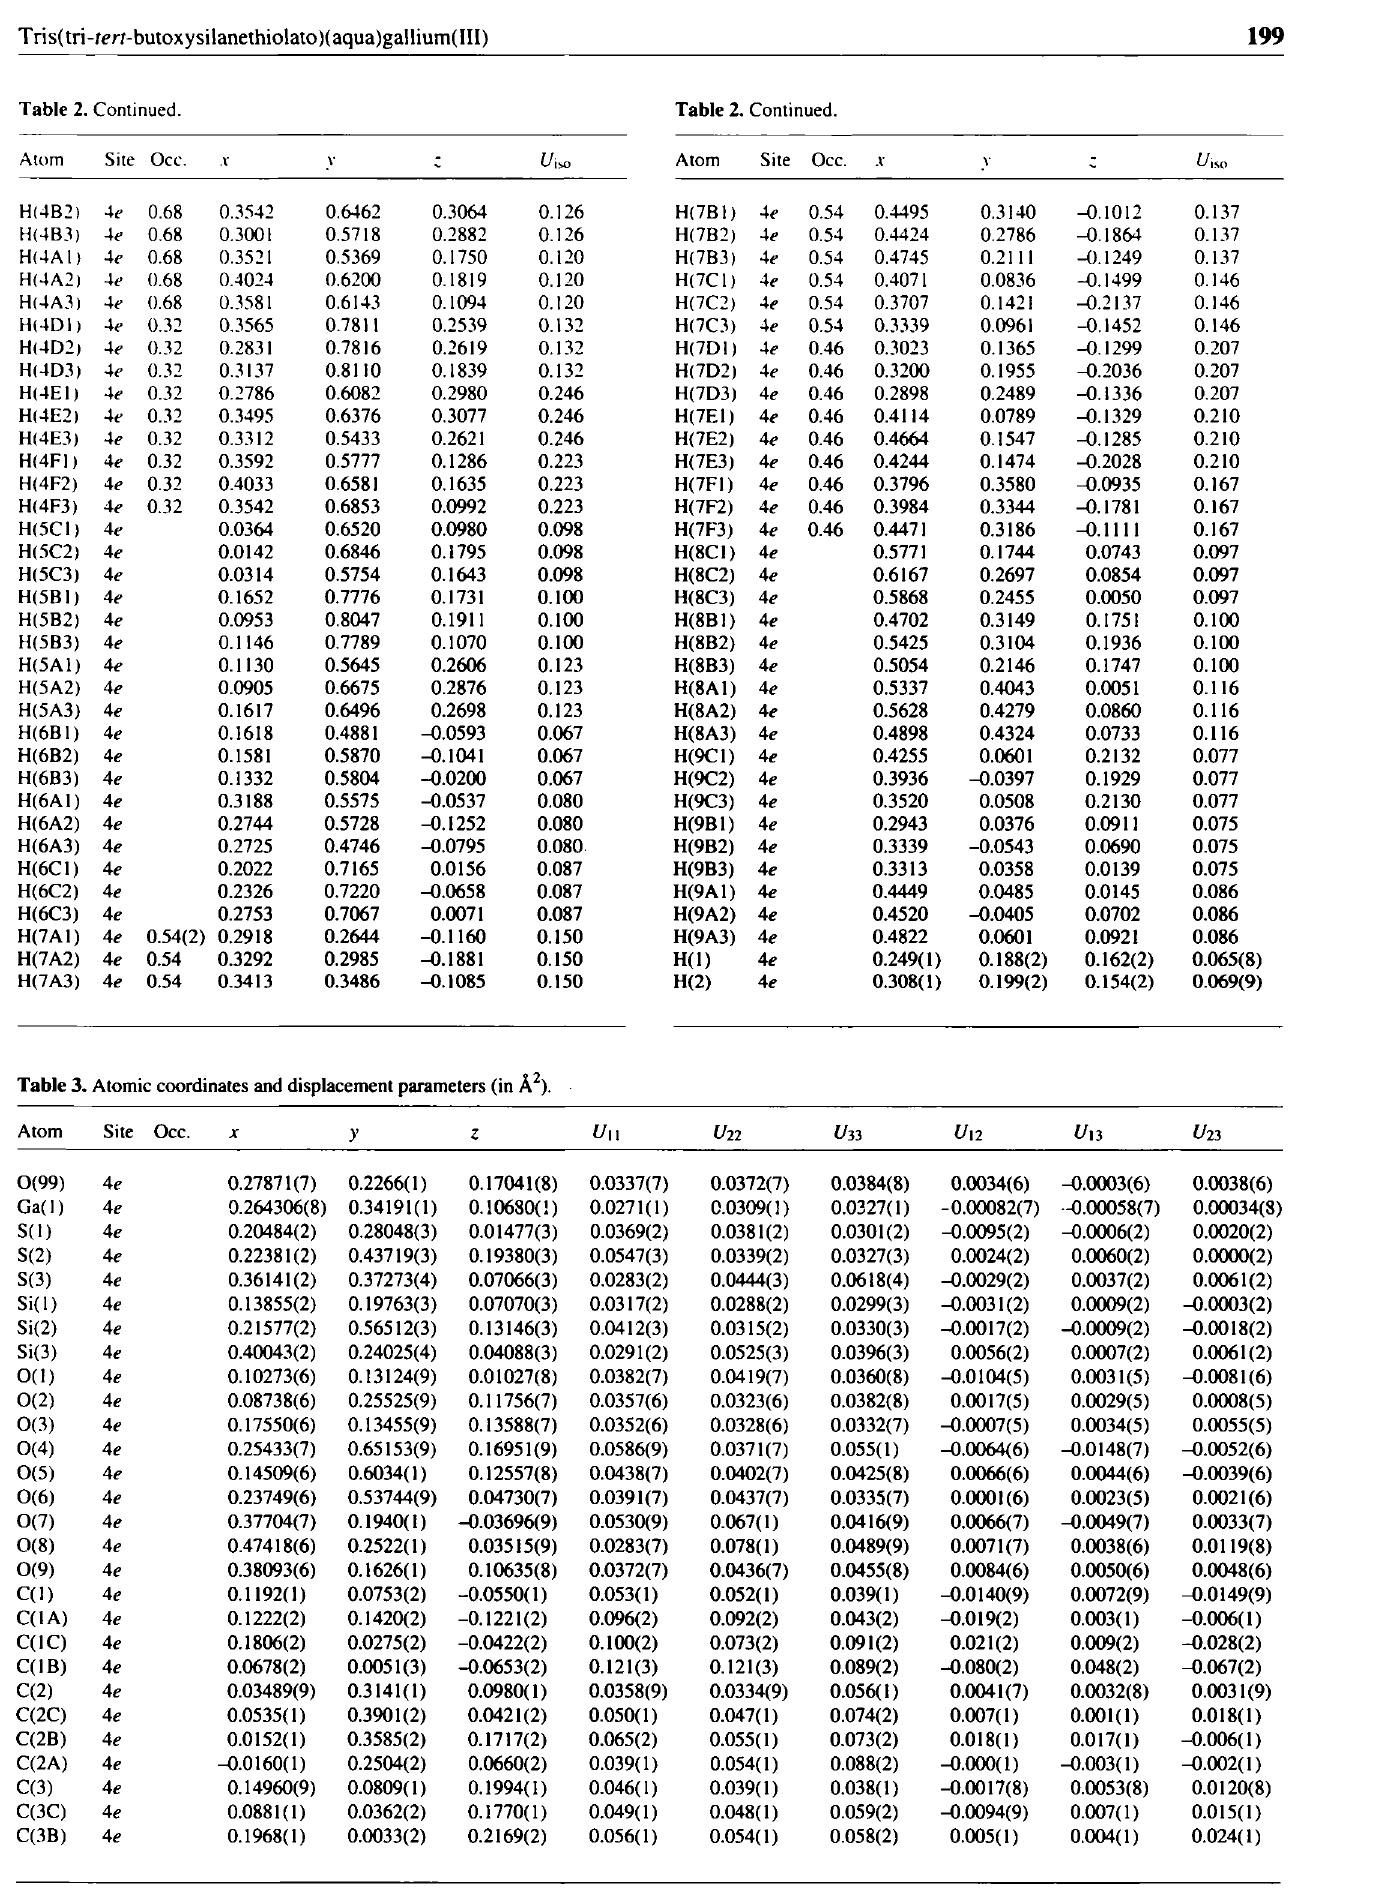
Table 3. Atomic coordinates and displacement parameters (in Ä 2